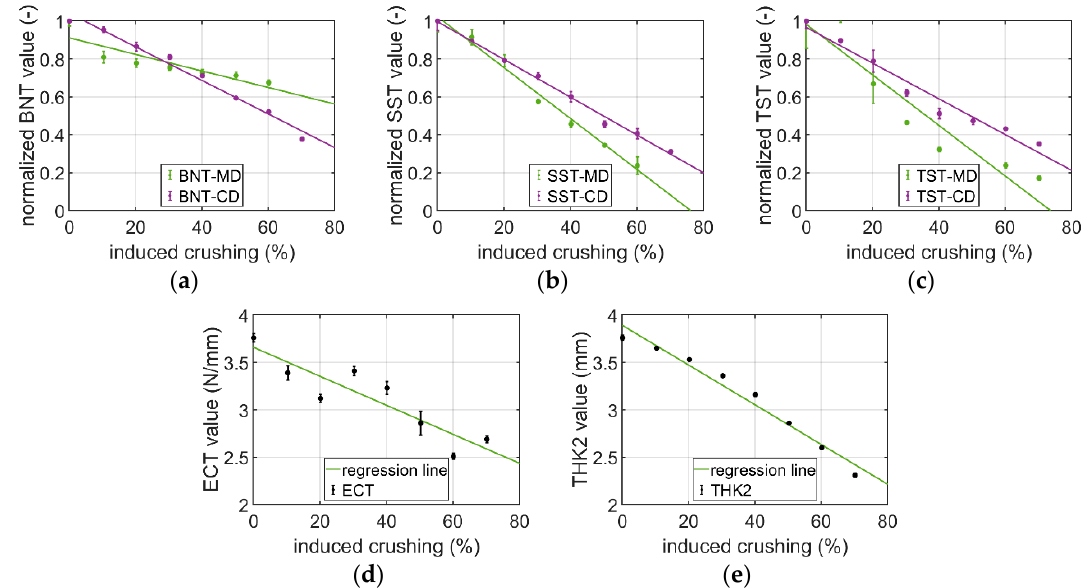
Figure 12. The decreases in measured values for C ‐ 340 corrugated cardboard in: ( a ) BNT; ( b ) SST; ( c ) TST; ( d ) ECT and ( e ) THK2.